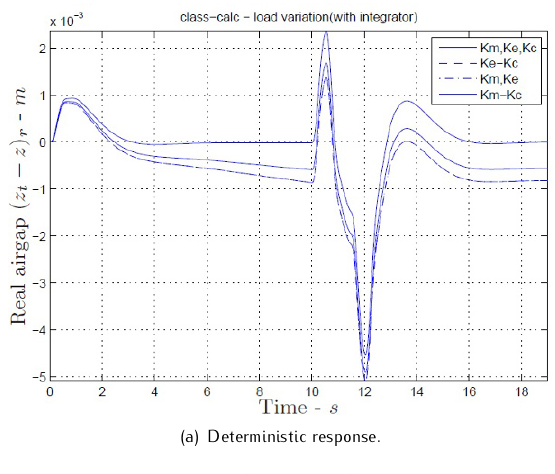
control configurations are included, the nominal one with K m − K e − K c and the other three represents the sensi- tivity under fault conditions. The other three frequency responses are the sensitivities for the control configura- tions K m − K e , K m − K c and K e − K c